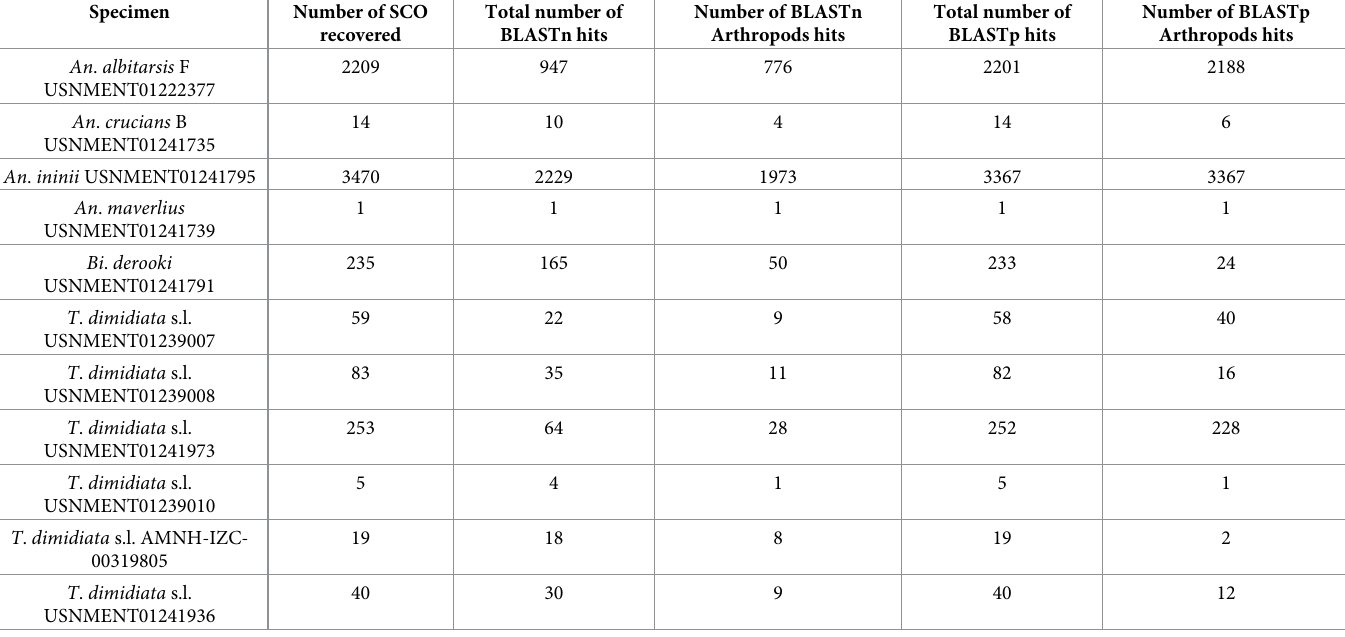
Orthograph, total contigs in the assembly (N), contiguity of the assembly (N50), sum of contig lengths (SUM), number of arthropod hits with BLASTn, number of arthropod hits with BLASTp. Variables that were found to be positively and significantly correlated (p < 0.05) were the number of SCO identified by Orthograph, N, N50, SUM, number of arthropod hits with BLASTn, number of arthropod hits with BLASTp (Table 6). No variables were found to be negatively correlated and, the age of the specimen was not significantly correlated to any of the other variables. When the recovered orthologs were blasted against the NCBI nucleotide (nt) and protein (nr) databases, with only the first hit being recorded, there was an almost perfect positive Table 5. Comparison between the number of SCO identified by Orthograph, the total number of BLASTn hits, the total number of BLASTn hits that correspond to known Arthropod sequences, the total number of BLASTp hits, the total number of BLASTp hits that correspond to known Arthropod sequences.